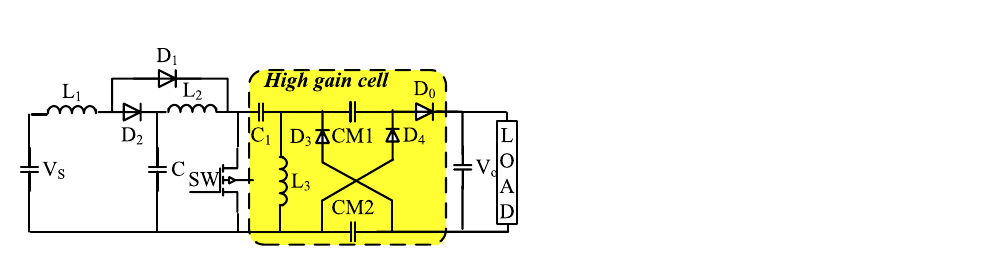
Figure 5. Proposed non-isolated high step-up DC/DC